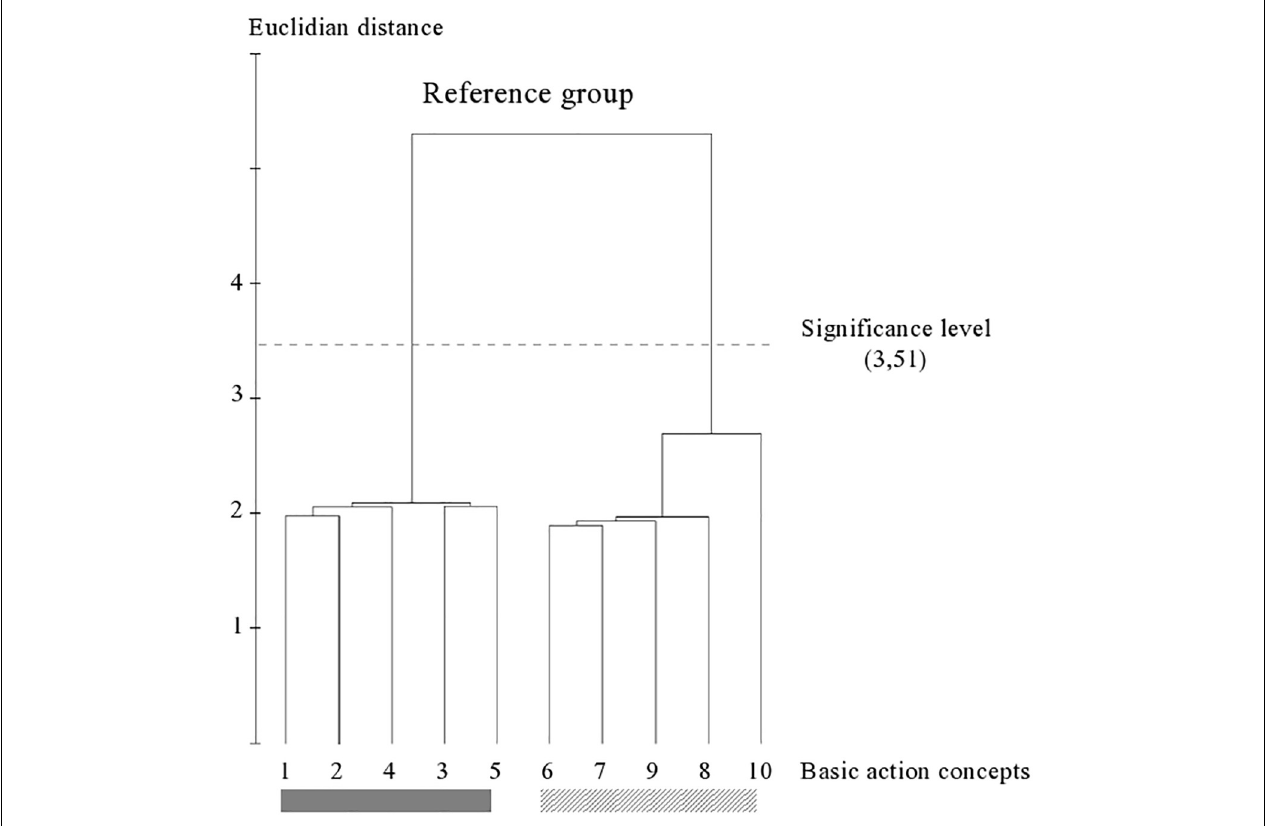
FIGURE 1 | Outcome of the hierarchical cluster analysis for the reference group ( N = 8, M age = 18 years) displayed as a dendrogram ( p = 5%; d crit = 3.51). The basic action concepts (BACs) are marked with numbers below the dendrogram. The resulting clusters are highlighted with the gray solid bar (pictures 1–5, technically correct BACs) and diagonally striped bar (pictures 6–10, faulty